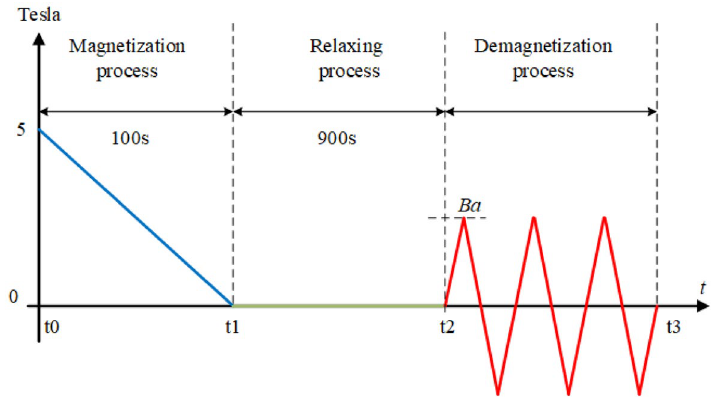
Figure 2. Sketch for the magnetization and demagnetization process. From t0 to t1, there is magnetizing applied magnetic field ( B app in Fig. 1), which is perpendicular to the tape surface. From t1 to t2 there is no magnetic field, and from t2 to t3 the applied magnetic field is parallel and oscillating (demagnetizing cross-field, B dem in Fig.